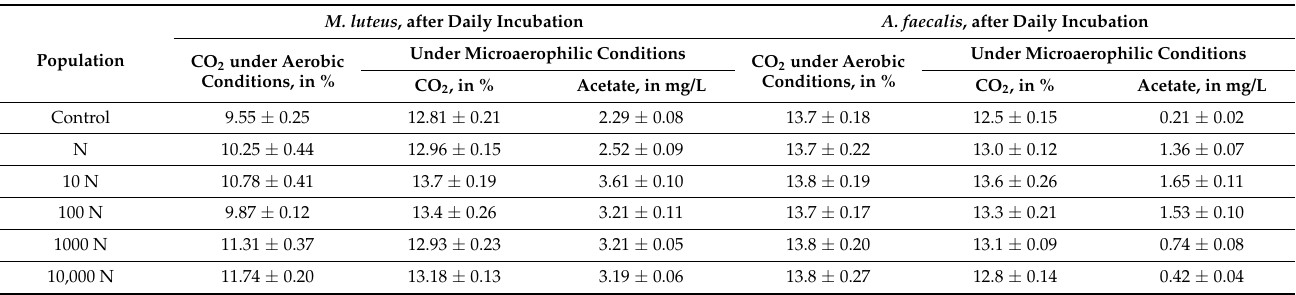
Table 1. Influence of BNP on the activity of M. luteus and A. faecalis under aerobic and microaerophilic